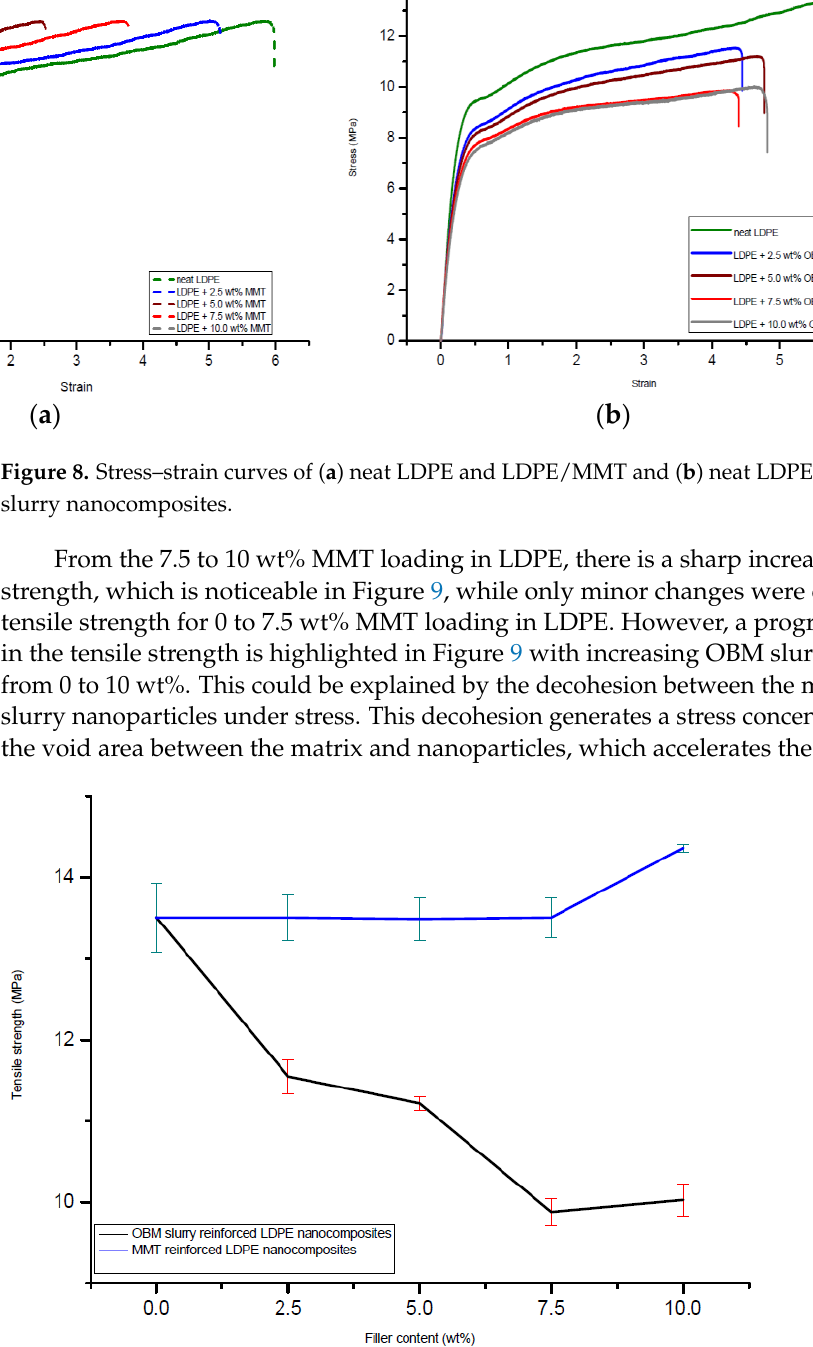
Figure 9. Comparison of tensile strength between LDPE/MMT and LDPE/OBM slurry nanocompo- sites considering tensile strength of neat LDPE as a baseline.